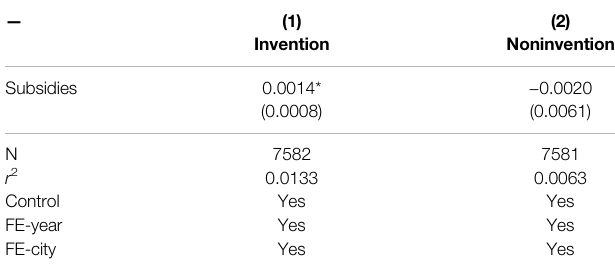
TABLE 11 | Green innovative strategies.